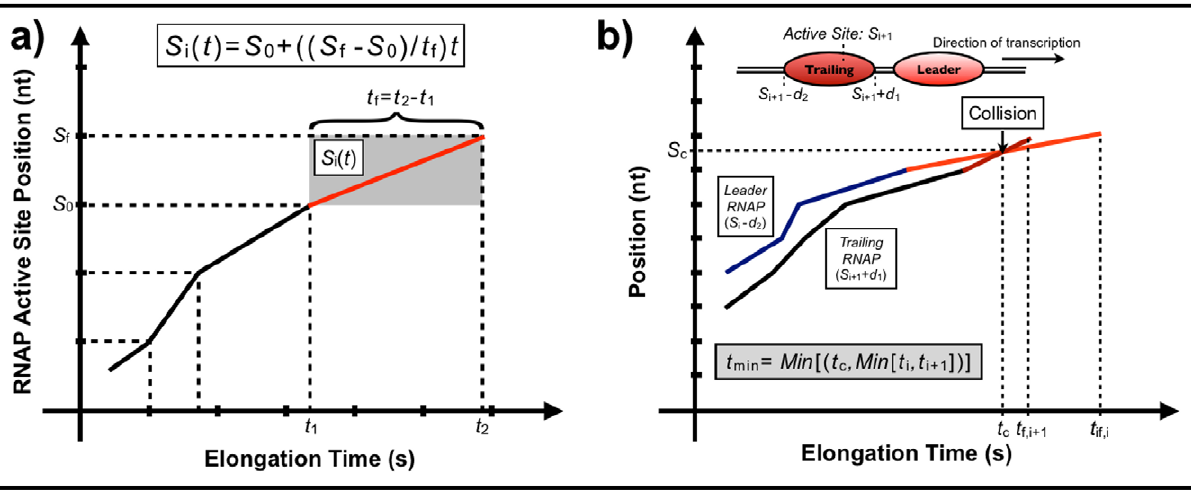
Figure 2. Representation of time evolution of RNAP: The red lines represent the last simulated step. a) The time evolution for a single molecule. We consider that the movement is uniform between each step. The velocity is assigned by the Gillespie algorithm. b) The method used to solve collisions. In blue we show the leader RNAP and in black the trailing RNAP. t c represents the required time for the collision. t min is the time for the first event among the following possibilities: nucleotide inclusion by trailing RNAP, nucleotide inclusion by leading RNAP or